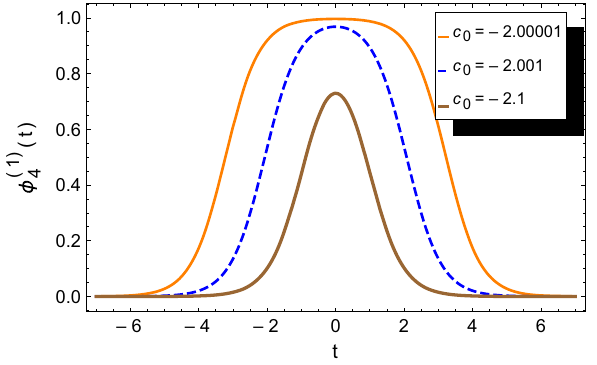
Fig. 3 Profiles of solutions φ 3 ( t ) (Eq. (28)) with λ 3 = 0 . 6